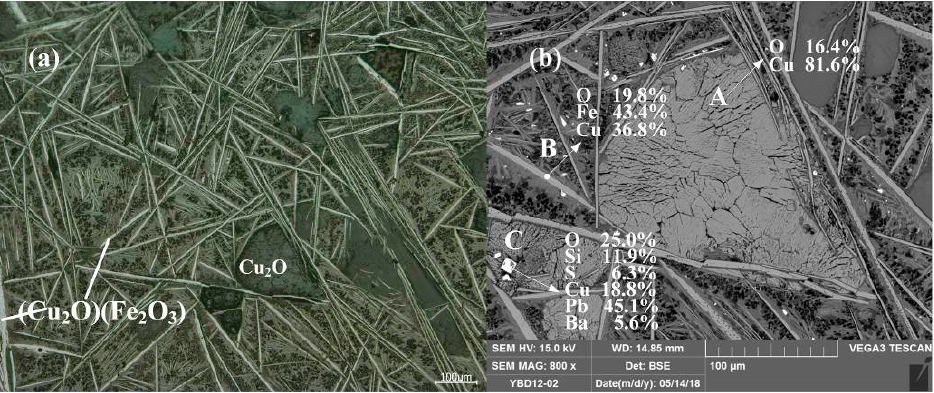
Figure 16. Optical micrograph ( a ) and SEM backscattered electron image ( b ) of YBD12. Sample YBD23: The main phases present in the slag were Fe 3 O 4 (magnetite) crystals, which were densely distributed between columnar grains of 2FeO·SiO 3 (fayalite). There were trace amounts of Cu 2 O (cuprite) present. No metallic copper particles were detected under examination using optical microscopy. As shown in Figure 17.